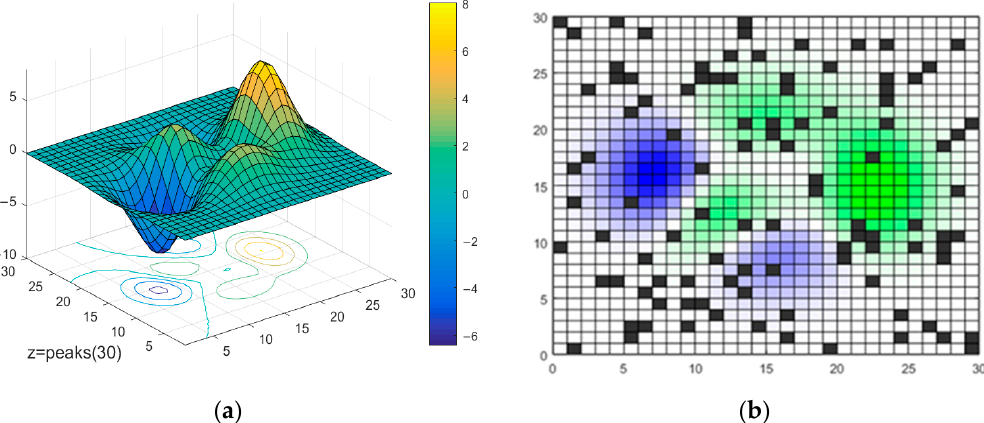
Figure 1. The modelling process of the 2D-H map. ( a ) The 3D map of peak function. ( b ) The 2D-H map generated by the peak function and obstacles.